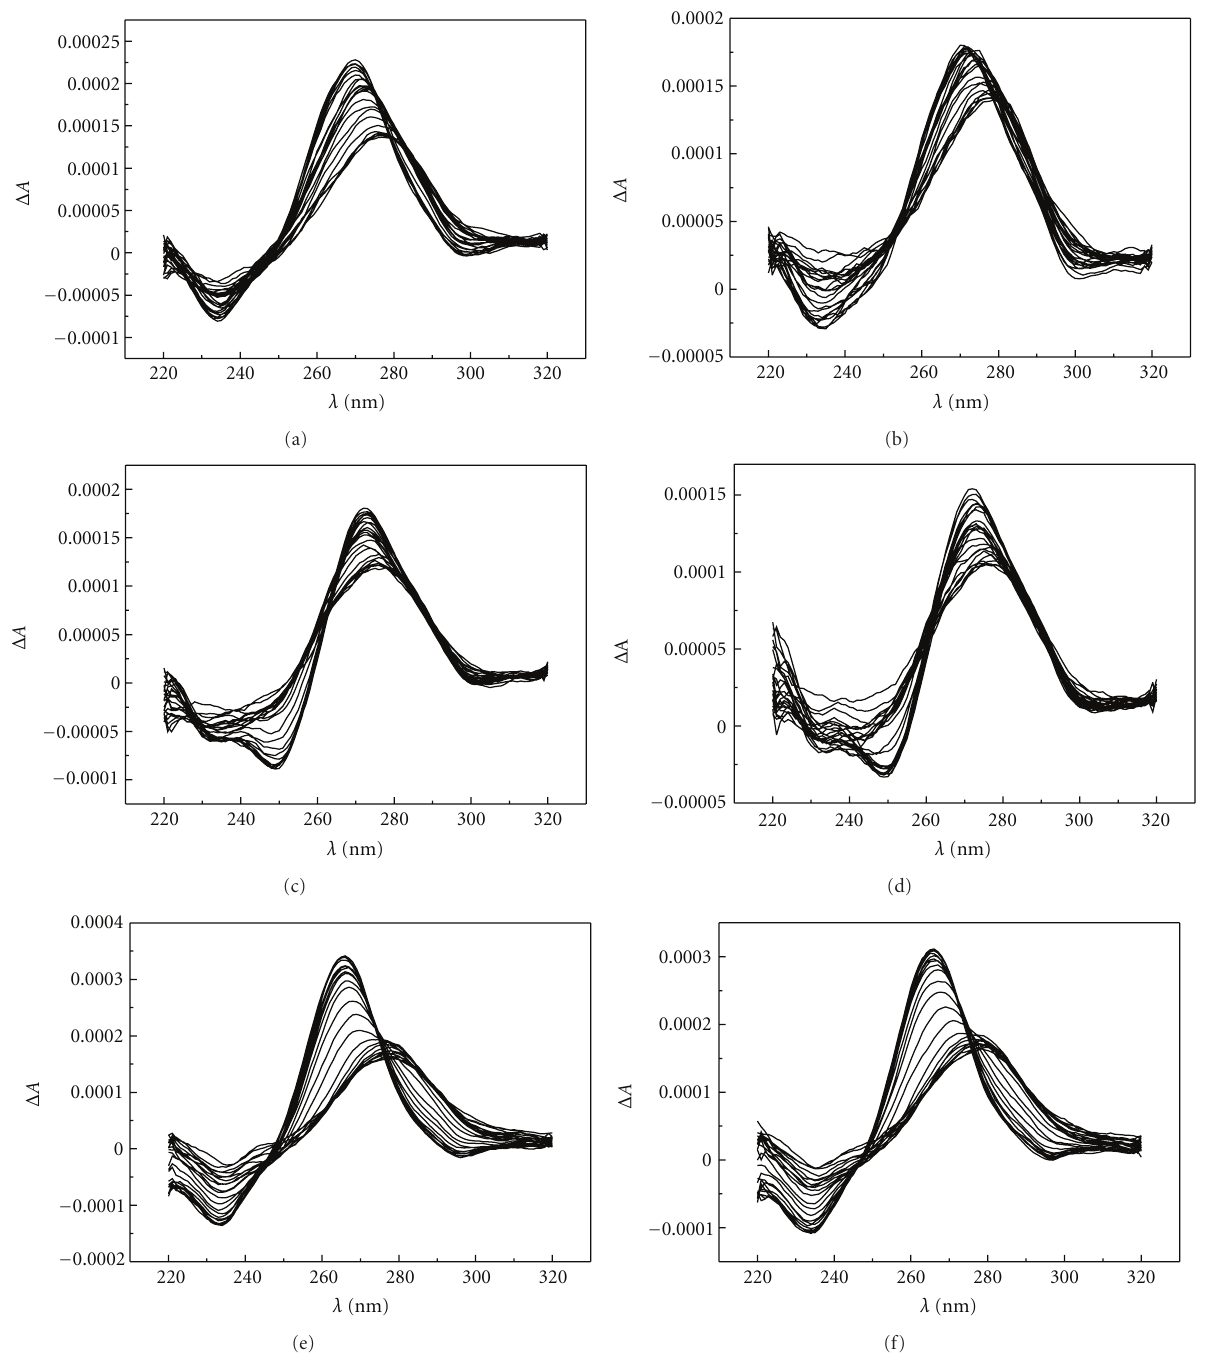
Figure 4: CD spectra of the duplexes formed between the modified ( 7X ) or unmodified ( 7A ) oligonucleotide and complementary DNA oligonucleotides having thymidine ( 10T ) or 2 (cid:2) -deoxycytidine ( 10C ) opposite to the artificial monomer (or adenosine) in the presence and absence of Pd 2+ ; [oligonucleotides] = 3.0 μ M, [K 2 PdCl 4 ] = 0/3.0 μ M, I (NaClO 4 ) = 0.1 molL − 1 , pH = 7.4. (a) 7X : 10T , (b) 7X : 10T + Pd 2+ , (c) 7X : 10C , (d) 7X : 10C + Pd 2+ , (e) 7A : 10T , (f) 7A : 10T + Pd 2+